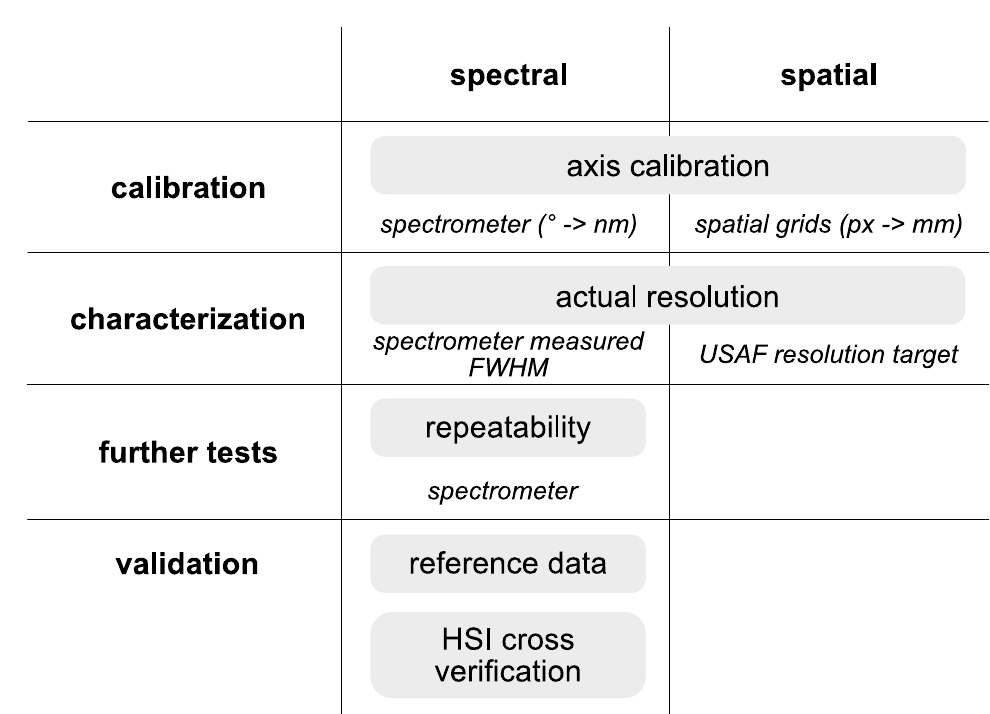
Figure 2. Protocol for calibration and validation of the hyperspectral microscope imaging (HMI) system. The core protocol is adapted from a general protocol proposed for spectral imaging systems with modifications specific to the monochromator-based imaging approach. Additionally, the validation step includes a comparison with a previously calibrated and validated hyperspectral imaging (HSI) system.